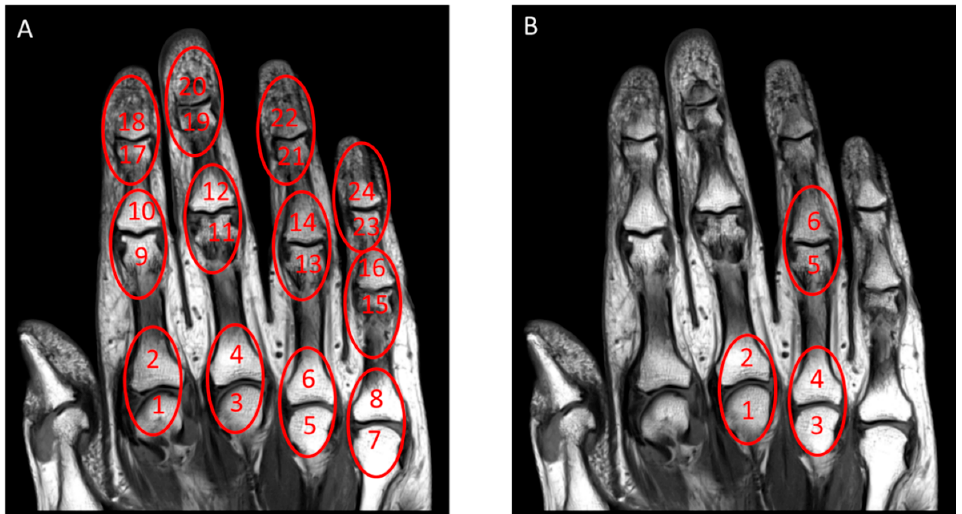
Figure 1. Joint regions and sub-regions in Psoriatic Arthritis Magnetic Resonance Imaging Score (PsAMRIS) versus simplified (s) PsAMRIS. Coronal T1-weighted MR image of a representative patient suffering from psoriatic arthritis (PsA). ( A ) In the full PsAMRIS, inflammatory and destructive changes associated with PsA are assessed in distinct regions and subregions of the hand. Circles indicate scored joints (i.e., regions), while numbers indicate joint sites (i.e., subregions). ( B ) Simplified (s) PsAMRIS. In A, 24 joint sites and/or 12 joints were evaluated, while in B, this number is reduced to 3 joints and/or 6 joint sites that were determined to be most responsive to clinical change.